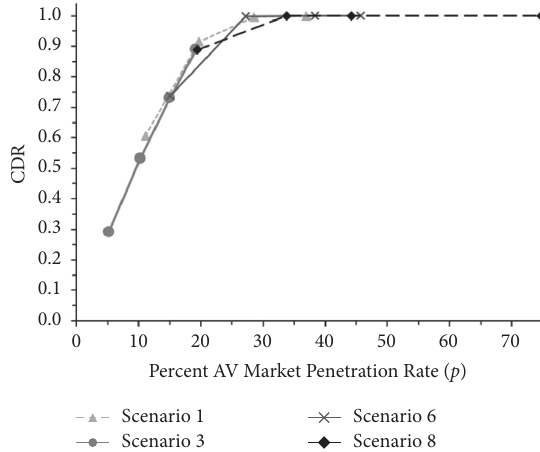
Figure 4: Effect of AV market penetration on CDR.